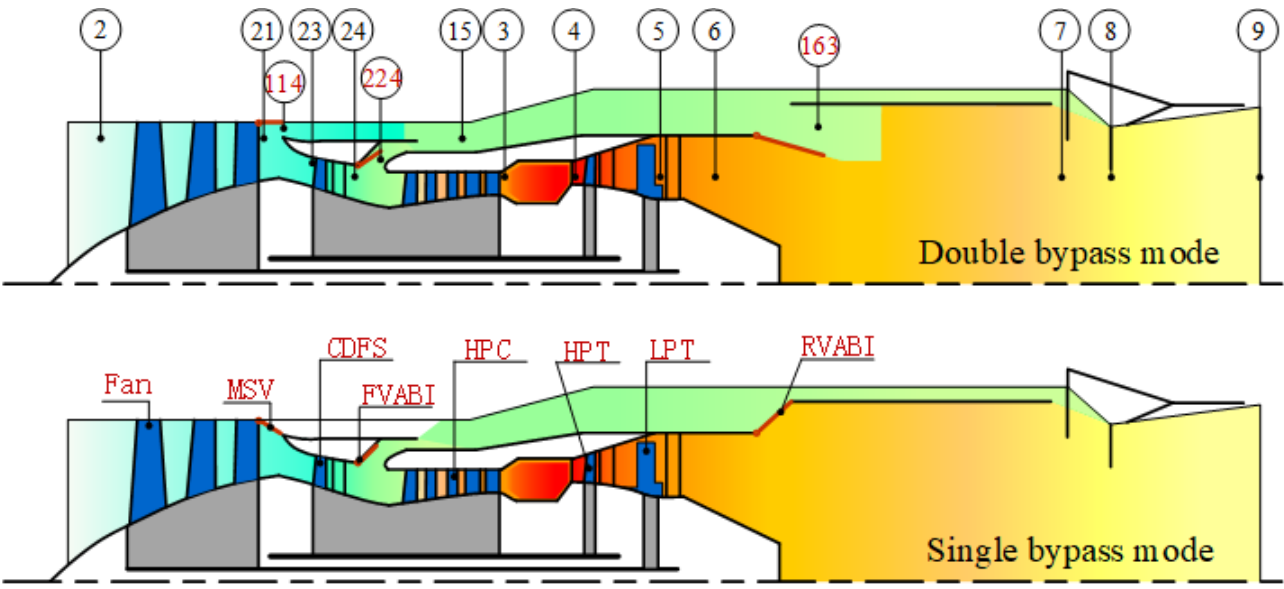
Figure 1. Structure diagram of a variable cycle engine.